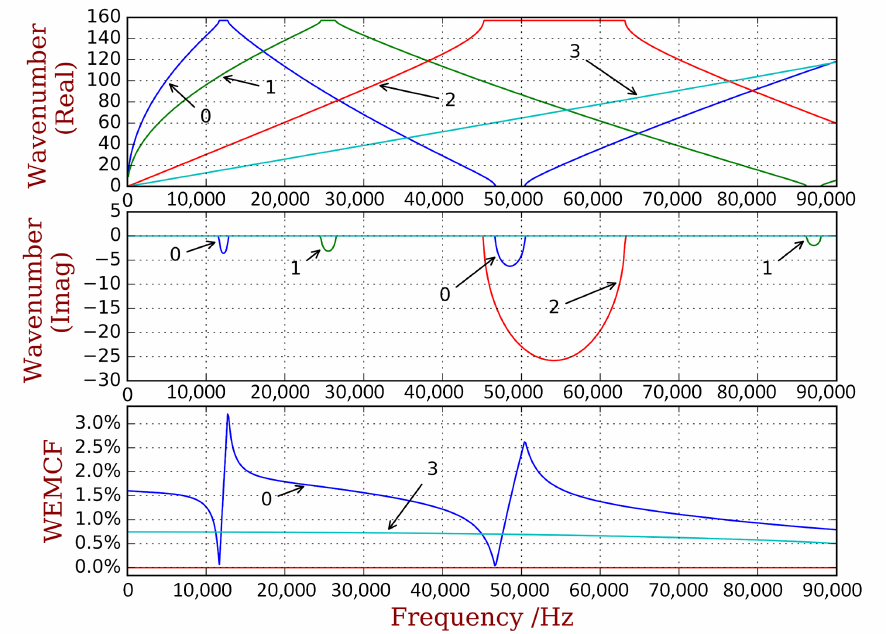
Figure 6. Dispersion curves and WEMCF for the piezoelectric waveguide with unit cell A: only wave 0 (z transverse) and 3 (longitudinal) have significant values.